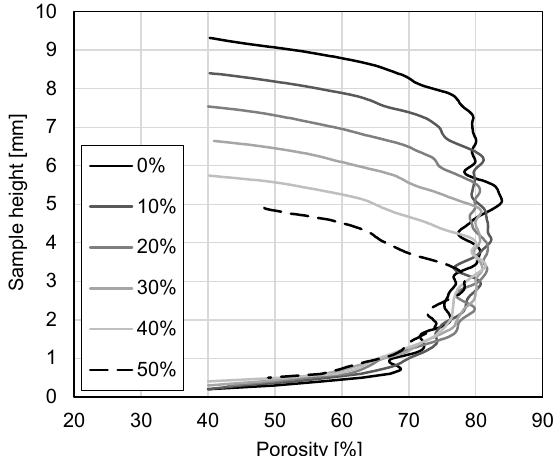
Figure 14. Cross-section porosity of APM foam sample 1 in dependence on the sample height and deformation.